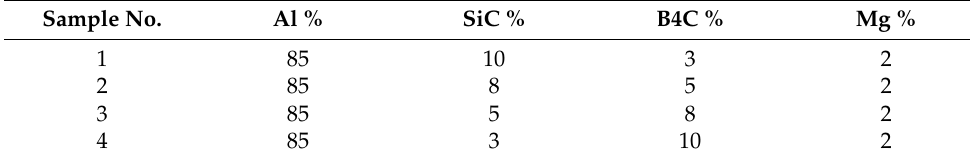
Figure 4. Schematic representation of FSW process and tool. Table 2. Composition of various samples in